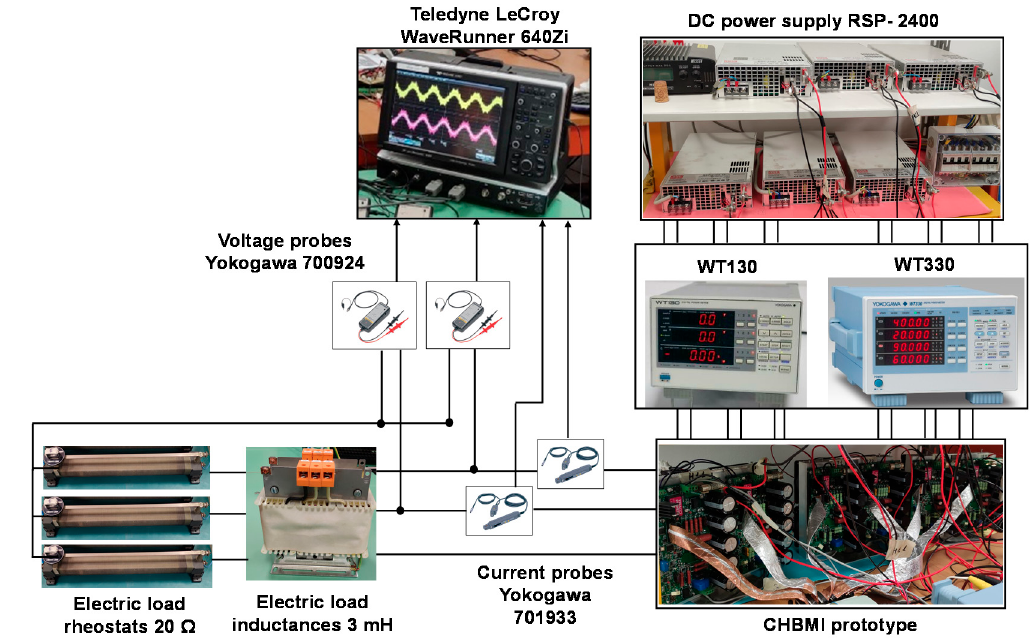
Figure 10. Schematic representation of the test bench.